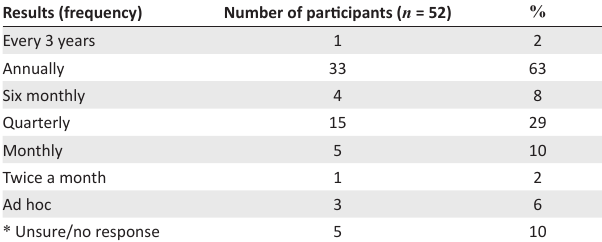
TABLE 2: Question 8b: Frequency of the identification of development needs.